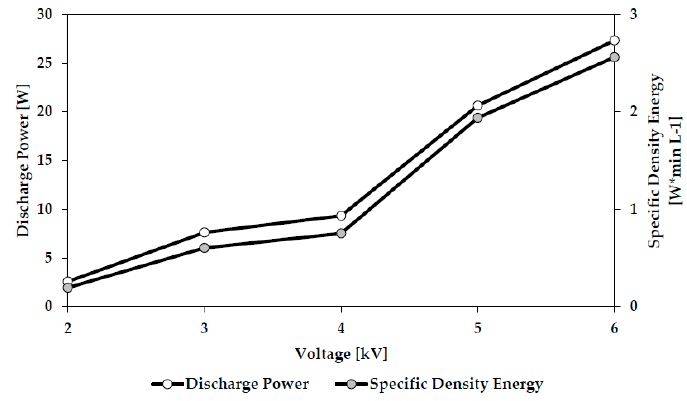
Figure 3. Plasma Discharge Power and Specific Energy Density vs. Applied Voltage used to generate the Helium Corona pin-to-plane plasma discharge of Figure 2.